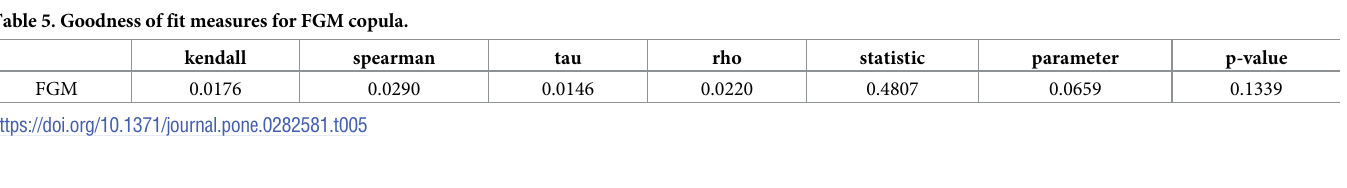
Table 6. MLE, SE, and CV for parameters of bivariate